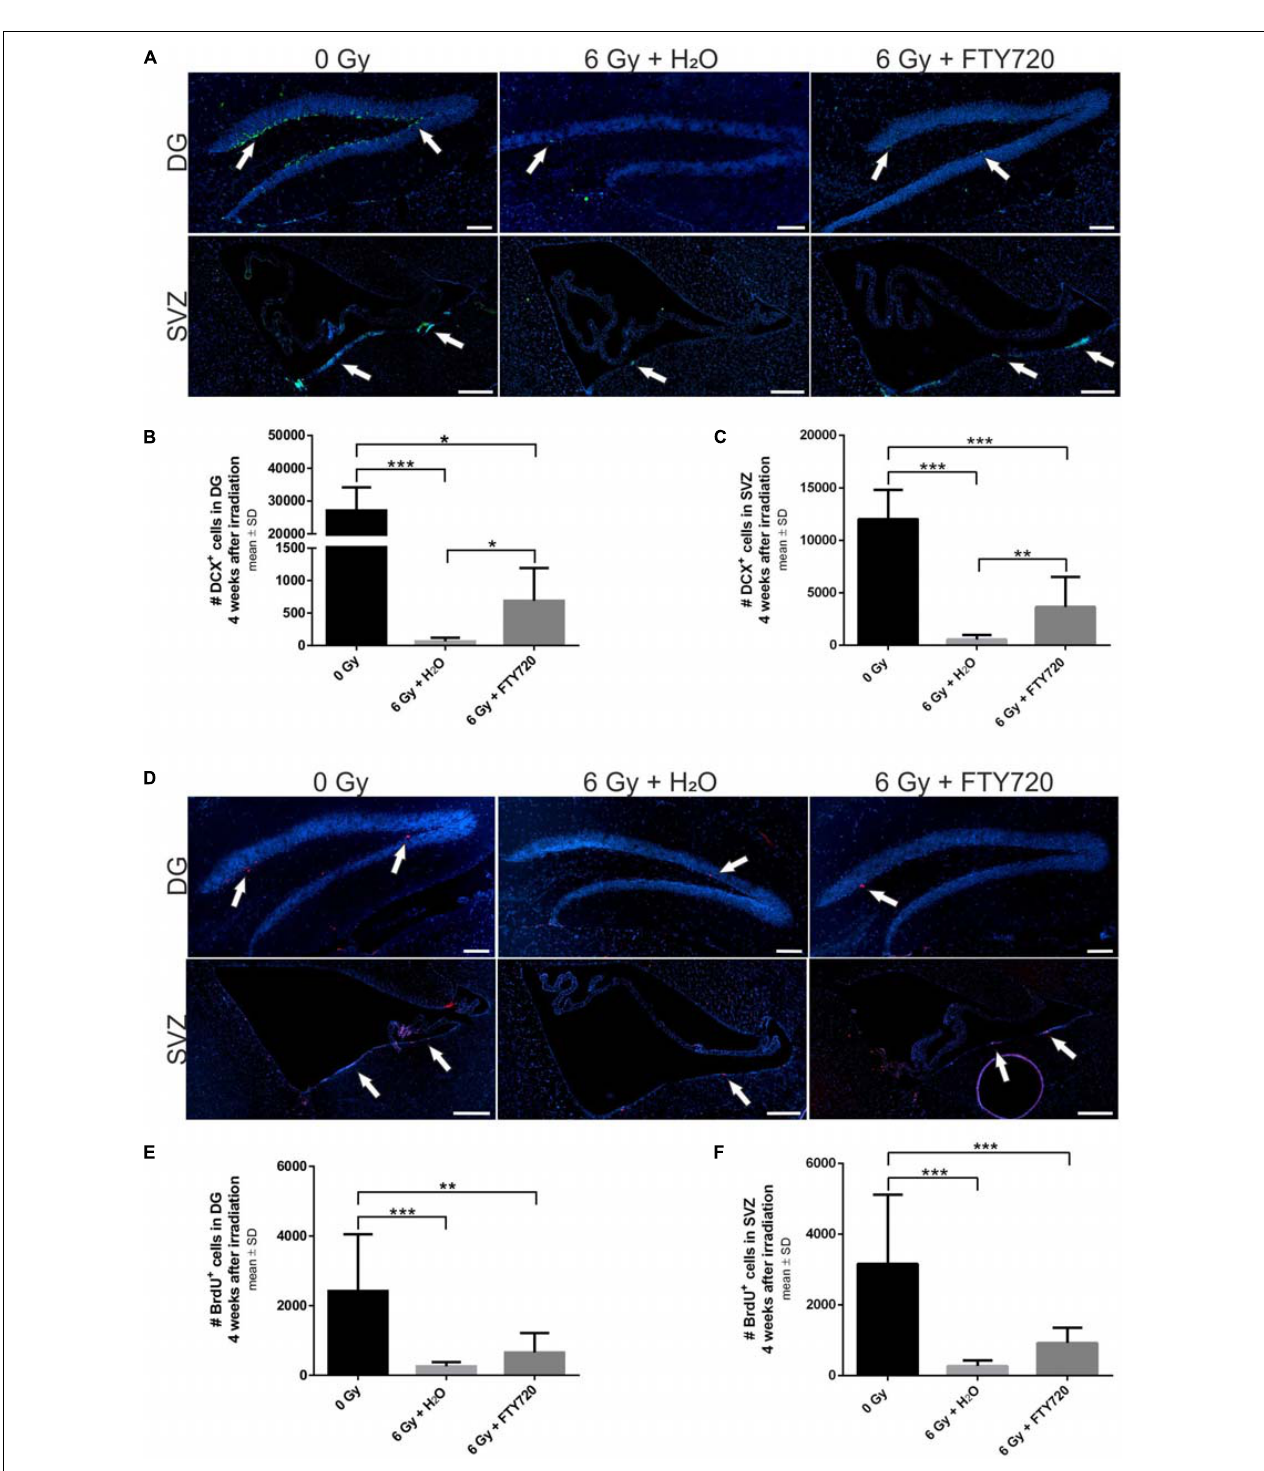
FIGURE 3 | Effect of FTY720 treatment on neurogenesis in adult mice 4 weeks after cranial irradiation. Mice were treated daily with FTY720 (1 mg/kg), received a whole brain irradiation with a single dose of 6 Gy after 7 days, and were sacrificed 4 weeks later. (A) Representative images of doublecortin positive (DCX + ) neurons in the dentate gyrus (DG, top) and the subventricular zone (SVZ, bottom). (B,C) Number of DCX + cells in the DG and the SVZ. (D) Representative images of proliferating cells in the DG (top) and the SVZ (bottom). Twenty four hours before perfusion all mice received a single dose of bromodeoxyuridine (BrdU, 200 mg/kg). (E,F) Number of BrdU + cells in the neurogenic niches DG and SVZ. 0 Gy: n = 12 mice, 6 Gy + H 2 O: n = 11 mice, 6 Gy + FTY720: n = 12 mice. Results are presented as mean ± SD. ∗ p < 0.05; ∗∗ p < 0.01; ∗∗∗ p < 0.001 (one-way ANOVA: C,F ; Kruskal–Wallis test: B,E ). Scale = 100 µ m (DG) or 200 µ M (SVZ). White arrows indicate DCX + (A) and BrdU + cells (D)